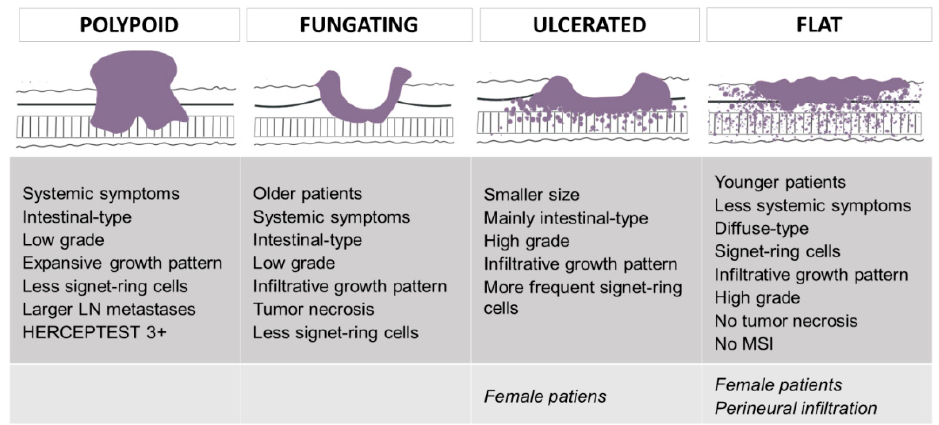
Figure 1. Main differential features of Borrmann types. Images designed by Alba Fernández Gutiérrez.